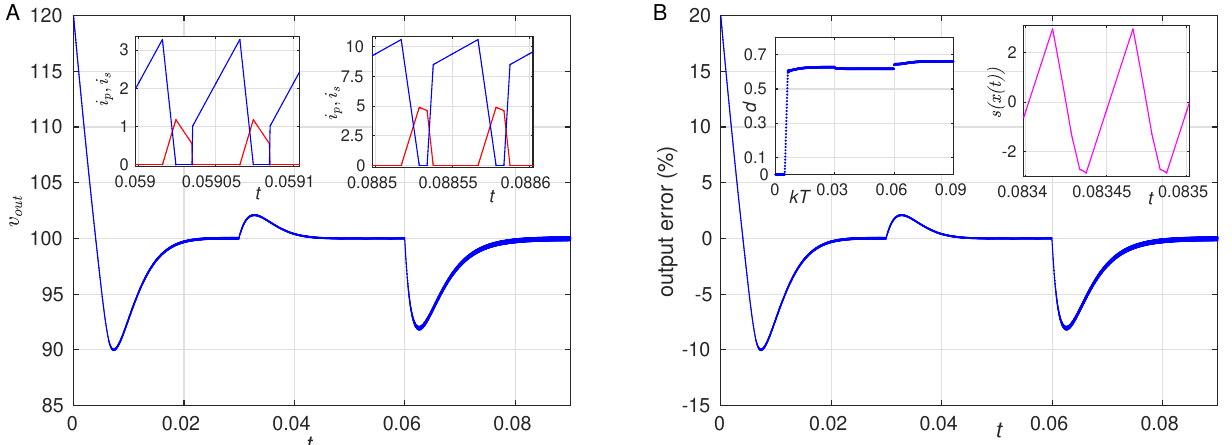
Figure 8. ( A ). Output voltage as a function of time with a disturbance in the resistance presented at t = 0.03 s and t = 0.06 s. Insets: primary (secondary) currents depicted in blue (red) before and after the change in v out . ( B ). Output error as a function of time for the evolution of v out in panel ( A ). Lower inset: dynamics of the duty cycle. Upper inset: function s ( x ( t )) defined in Equation (2). In this figure, the parameters have been chosen as in Table 2, with load variation from R = 200 Ω to R = 350 Ω to R = 80 Ω